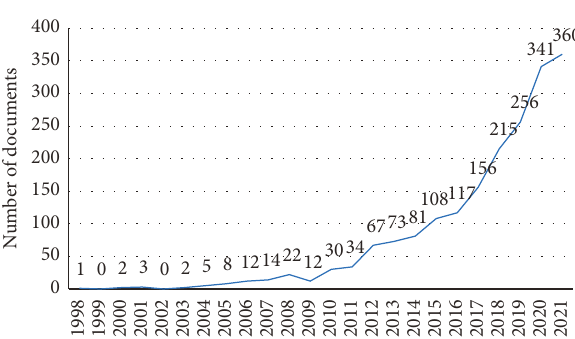
Figure 1: Time distribution of the number of publications in the international research literature on business